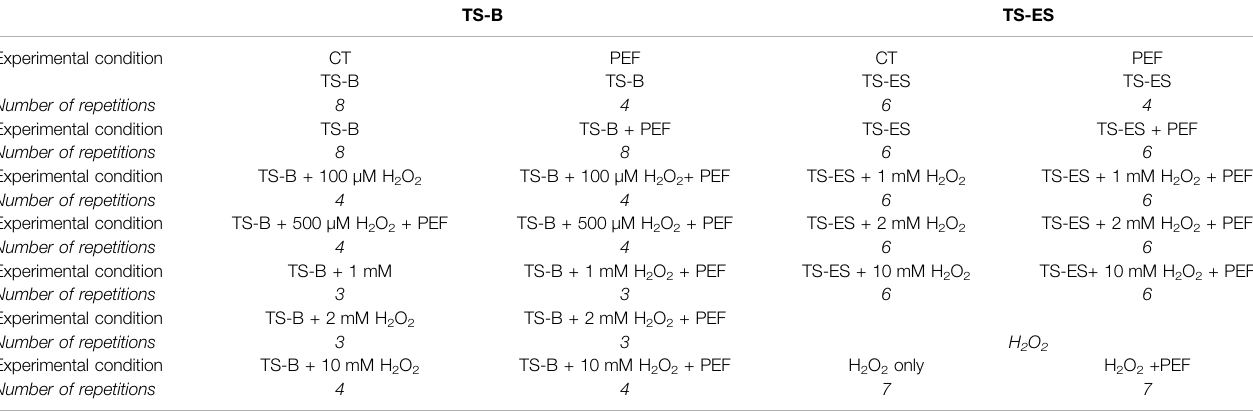
TABLE 1 | Number of repetitions of E. coli antibacterial experiment for the different experimental